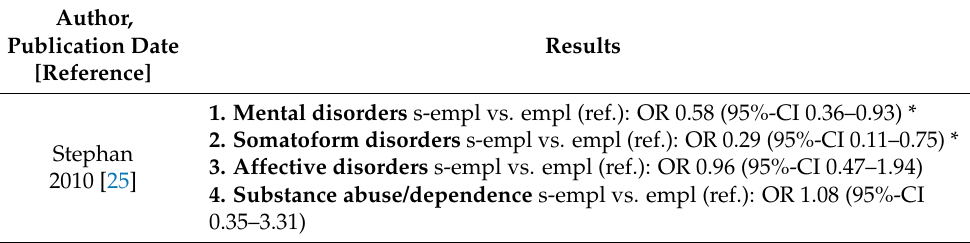
Table 5. Mental illness, at least one —results of cross-sectional studies of good quality on mental disorders comparing self-employed (s-empl) vs. employees (empl).